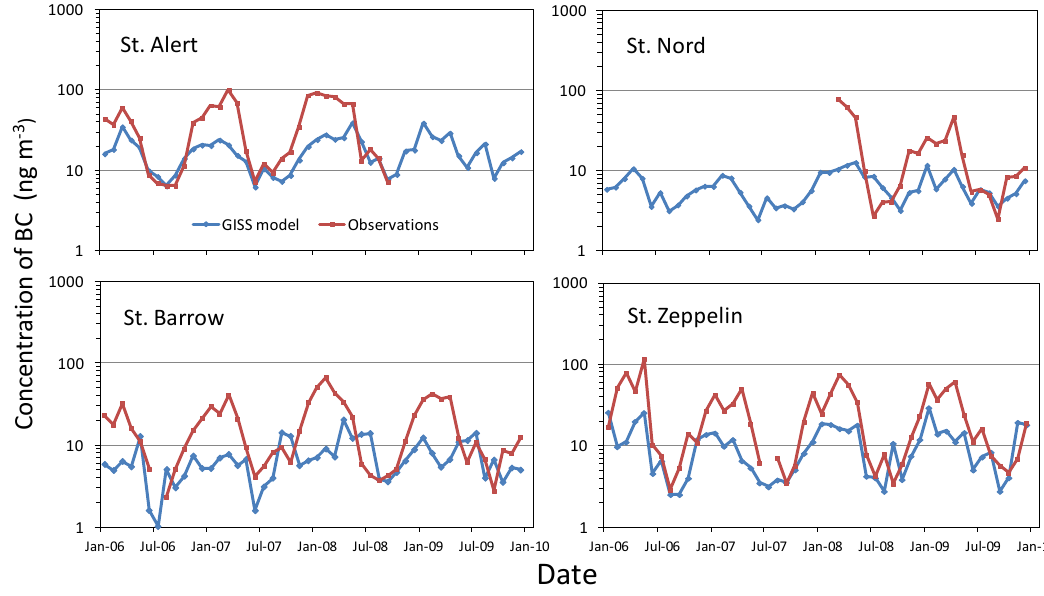
Fig. 5. Comparison of modeled monthly aBC concentrations in near surface layer versus measured concentrations for Alert (83°N, 62°W), Barrow (71°N, 157°W), Zeppelin (79°N, 12° E) and Nord (81°N, 16°W) station from January 2006 to December